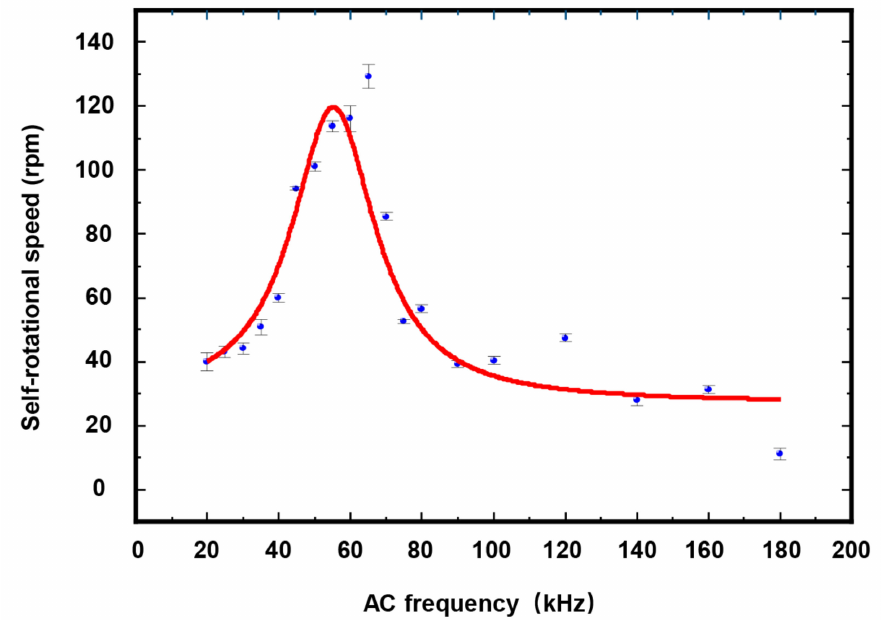
Figure 14. Self-rotational speeds of Raji cells with different AC frequencies at an external AC bias potential of 10 V pp . The measurement points in this figure were obtained for one Raji cell only. At each measurement point, the period of stable continuous cell rotation was selected for measurement, and the number of cell rotation periods was {3, 3, 5, 6, 4, 5, 5, 5, 5, 3, 5, 6, 5, 5, 3, 5, 2, 2, 2, 2, 2, 3, 2}. In the figure, each data point represents a mean ± maximum